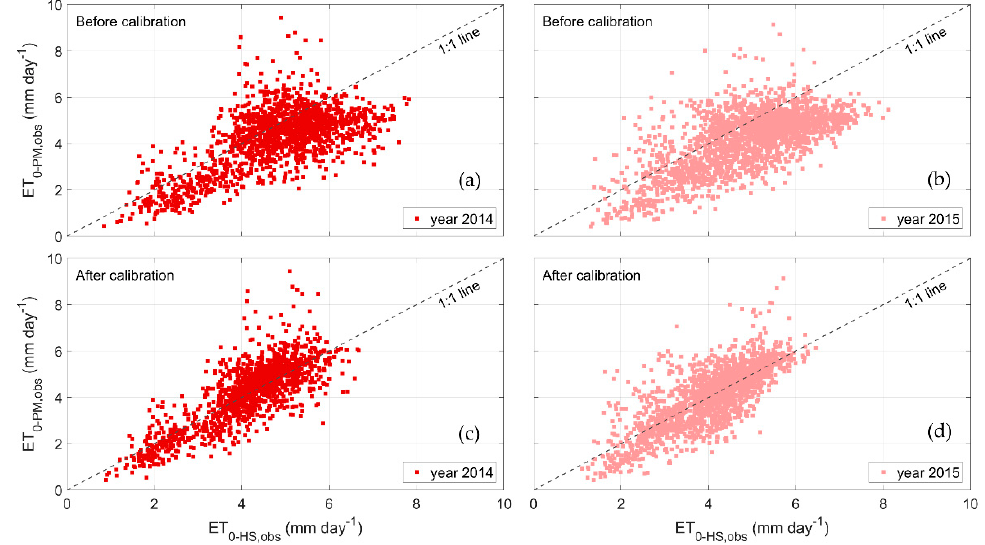
Figure 5. Scatter plots of ET 0-PM,obs versus ET 0-HS,obs before ( a , b ) and after calibration ( c , d ): ( a – c ) year 2104; ( b – d ) year 2105.